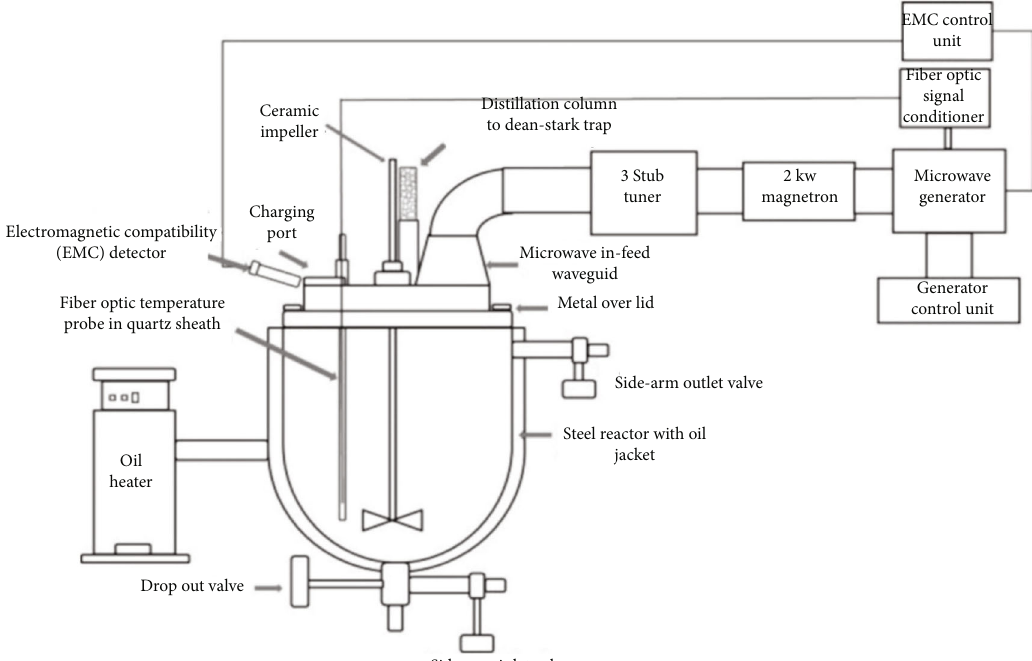
Figure 16: Schematic representation of the reactor with MW generator and oil-heated jacket (reprinted from Buttress et al. [95] with permission. Copyright © 2019 Elsevier Ltd.).